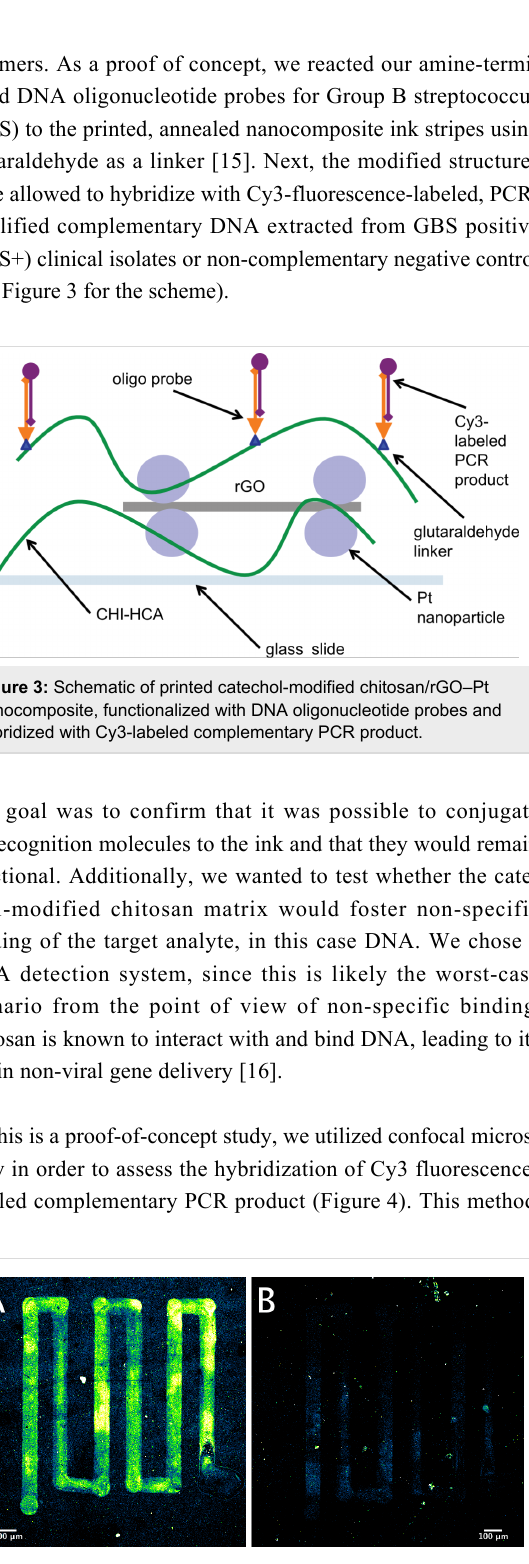
Figure 4: Confocal microscopy of printed, annealed rGO–Pt ink func- tionalized with DNA oligonucleotide probes. A) Results of hybridization with complementary, GBS+ Cy3-labeled PCR product. B) Results of hybridization with non-complementary, control Cy3-labeled PCR prod- uct.